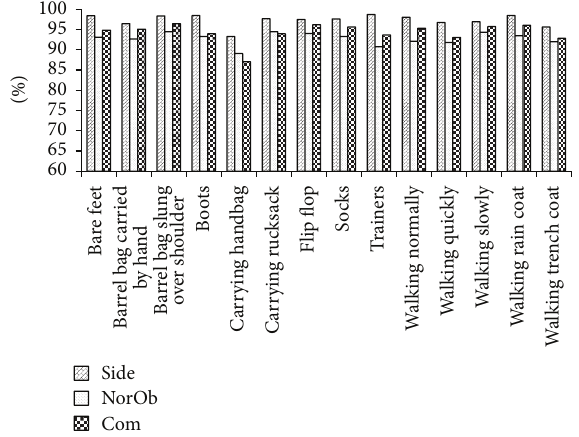
Figure 16: CCRs of individual covariate factor for SOTON Small